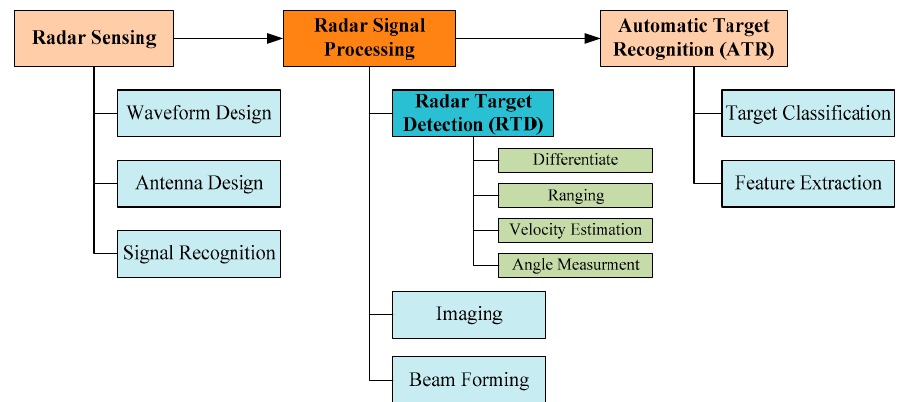
Figure 1. Radar tasks that can benefit from deep learning.